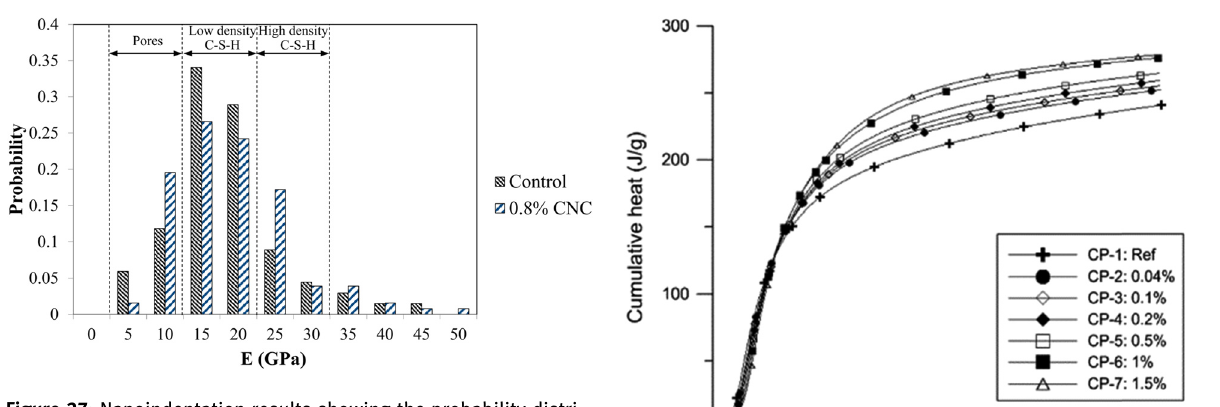
Figure 27: Nanoindentation results showing the probability distri - bution of Young ’ s modulus of CNC - reinforced cement corresponding to 28 days of curing, reprinted with permission from ref. [ 78 ] ; Copyright 2017, MDPI.